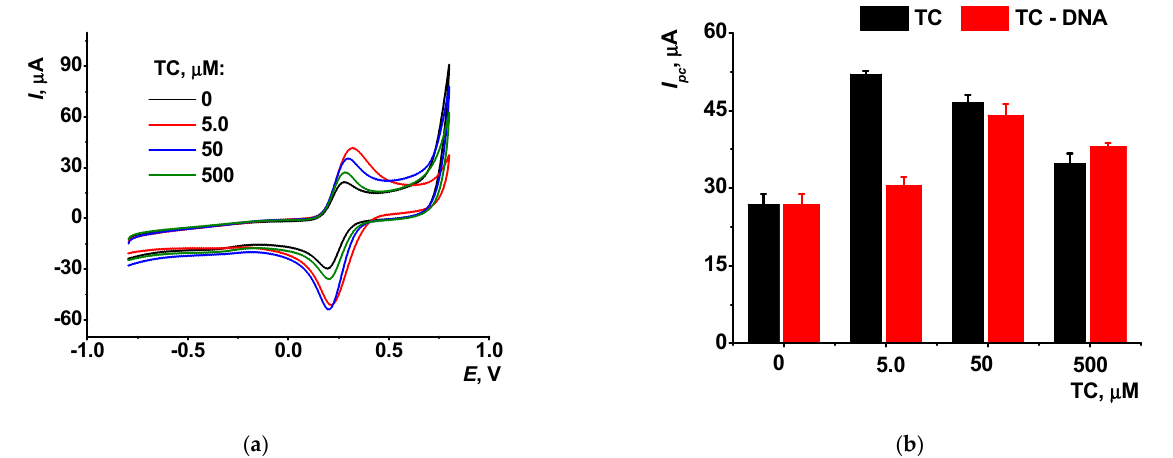
Figure 2. ( a ) Cyclic voltammograms of 5.0 mM K 3 [Fe(CN) 6 ] recorded on the GCE covered with CB (2 μ L of 1.35 mg/mL suspension in 0.375% chitosan) and TC (5 μ L per electrode. ( b ) The comparison of the reduction peak currents recorded on the same electrode with and without DNA (0.4 mg/mL) for various TC concentrations. Average ± S.D. for four individual sensors.